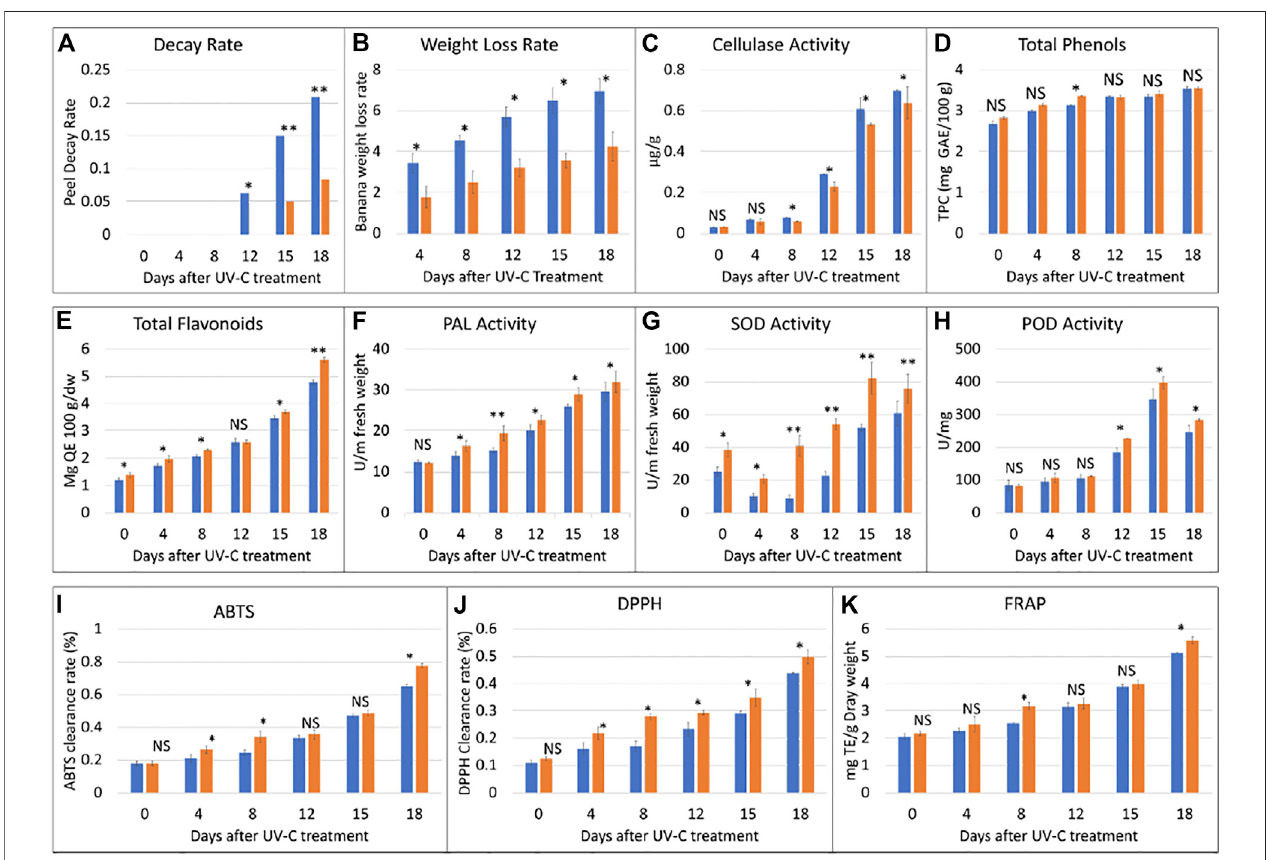
FIGURE 2 | Physiological index analyses of banana peel treated with UV-C (0.02 kJ/m 2 ) or without UV-C (CK) for 0, 4, 8, 12, 15, and 18 days. (A) peel decay rate, (B) weight loss rate, (C) cellulase activity, (D) total phenols, (E) total fl avonoids, (F) phenylalanine ammonia lyase (PAL) activity, (G) superoxidase dismutase (SOD) activity, (H) peroxidase (POD) activity, (I) 2, 20 -azinobis-(3-ethylbenzothiazoline-6-sulfonic acid) (ABTS), (J) 1,1-diphenyl-2-picrylhydrazyl radical scavenging capacity (DPPH), and (K) ferric reducing antioxidant power (FRAP). The error bars represent standard deviation. The ns, *, and ** show that the differences between UV-C and CK treatments are non-signi fi cant, signi fi cant, and highly signi fi cant, respectively. The blue and orange bars represent CK and UV-C treated banana